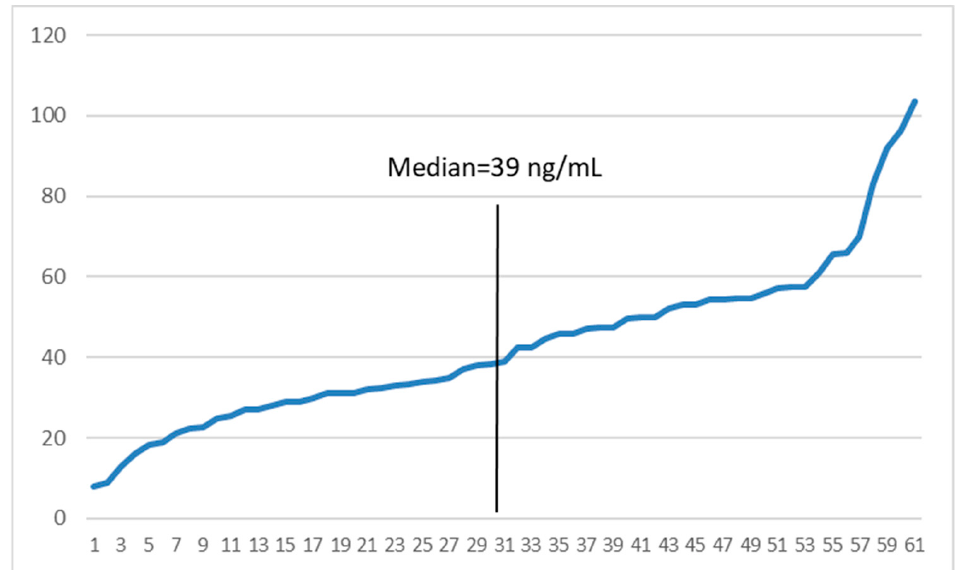
Figure 2. IRT values (ng/mL) and median for 61 CFFN cases in 11 states (sorted lowest to highest). CFFN, false screen negative CF cases due to IRT below program cutoffs; IRT, immunoreactive tryp- sinogen.